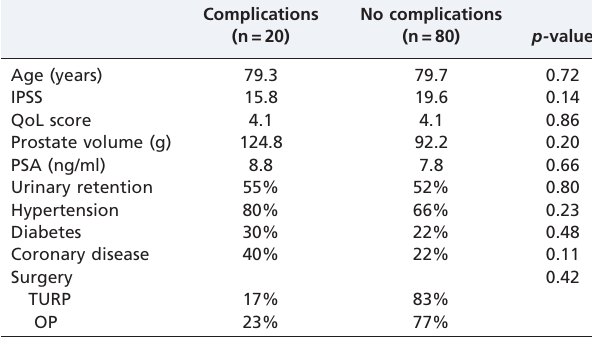
Table 1 - Patient characteristics according to the incidence of